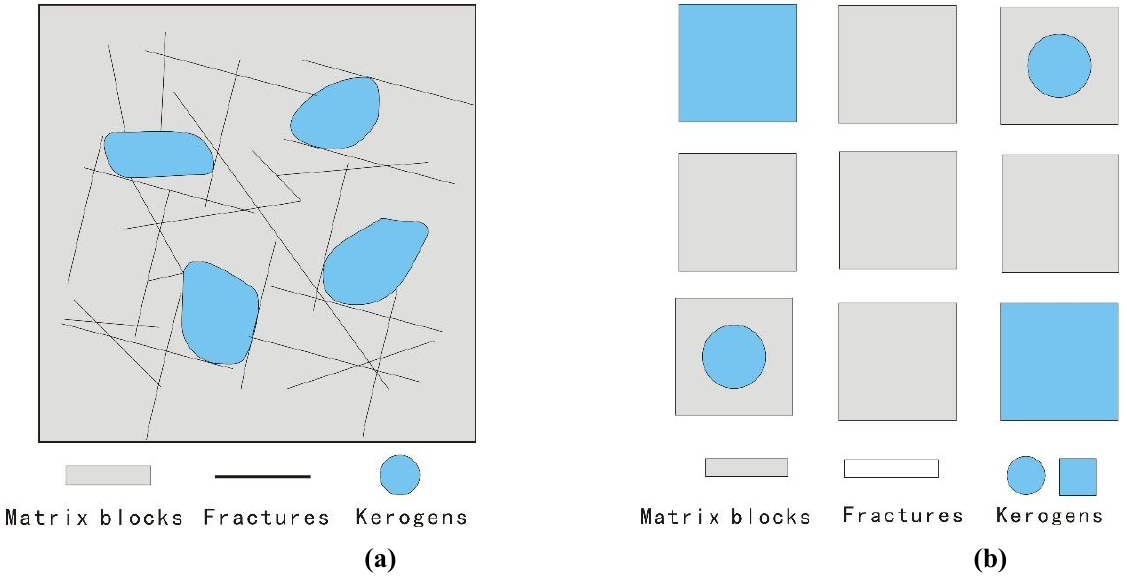
Figure 4—The first type of triple porous media (F-TPM). Real physical model. (b) Ideal physical